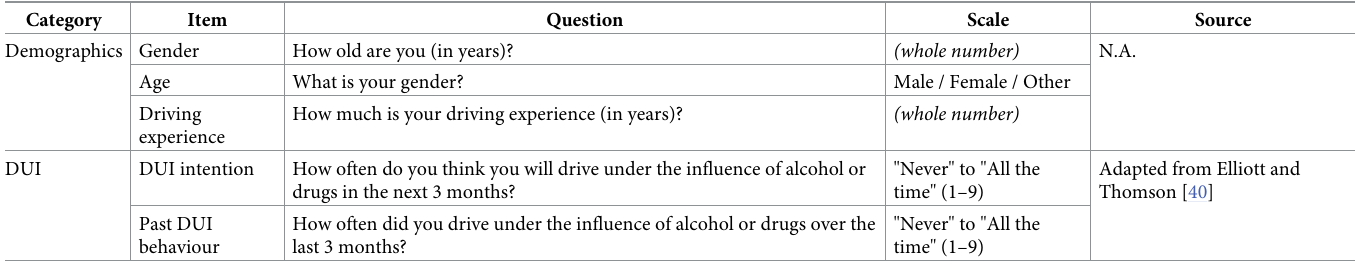
Table 1. Measured